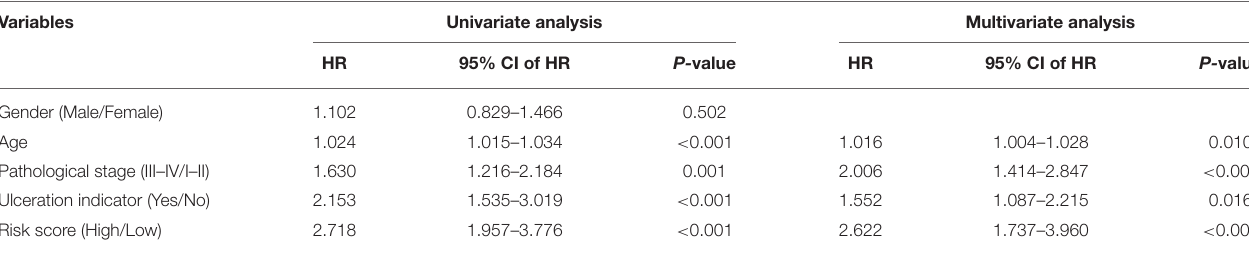
TABLE 3 | Univariate and multivariate Cox regression analyses of clinical features and risk score with OS. Variables Univariate analysis Multivariate